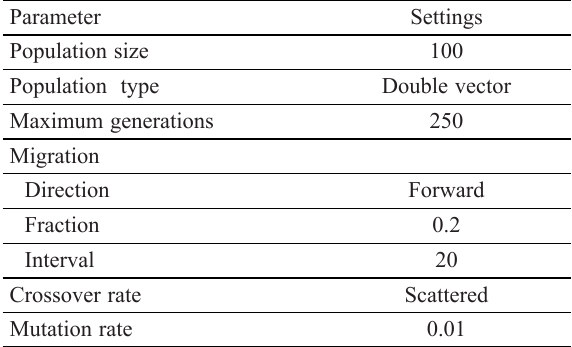
Table 2. Parameter settings for GA